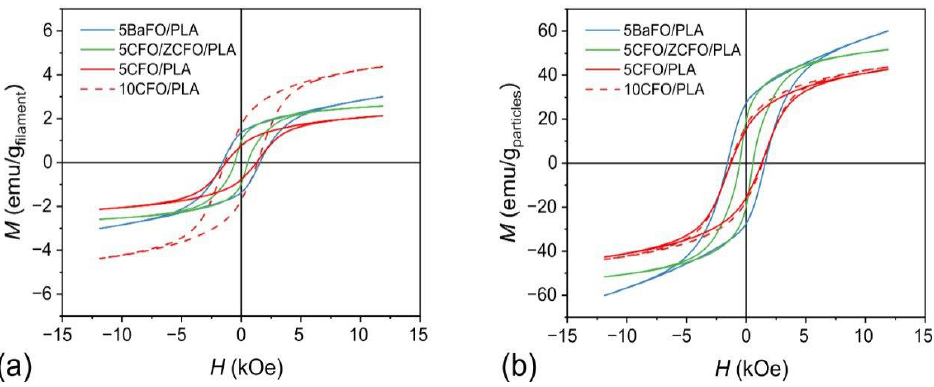
Figure 3. Room-temperature field-dependent magnetization curves measured for all samples of magnetic filaments. The magnetization is normalized to ( a ) the mass of the filament, and ( b ) the nominal content of the magnetic filler.